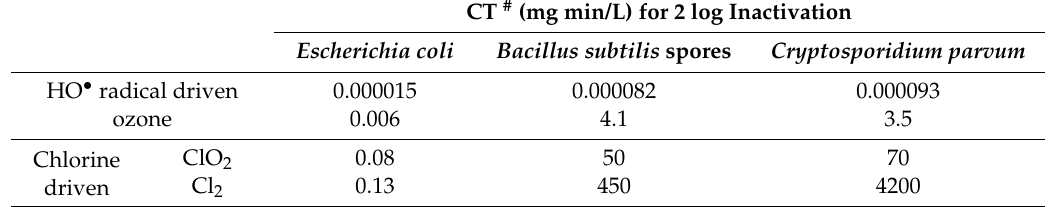
Table 4. CT values required by different disinfection methods for 2 log inactivation of selected pathogens from water.